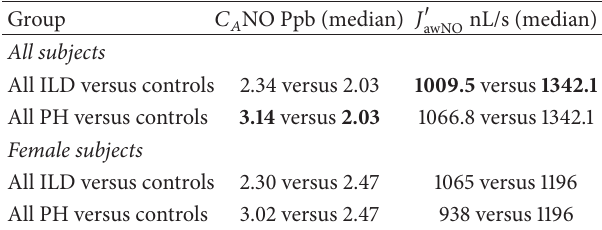
Table 2: Comparison of exhaled nitric oxide values between groups.